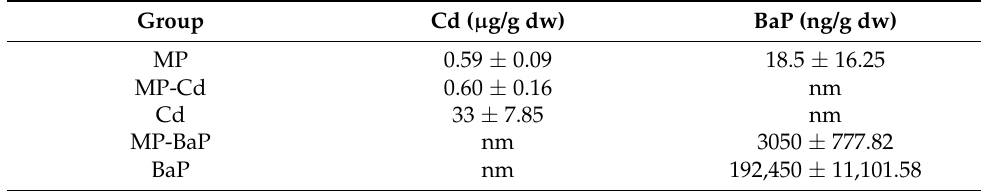
Table 3. Results of the chemical analyses of Cd and BaP concentrations in mussels exposed to pristine or contaminated MPs, or to dissolved contaminants. Data are expressed as mean ± standard